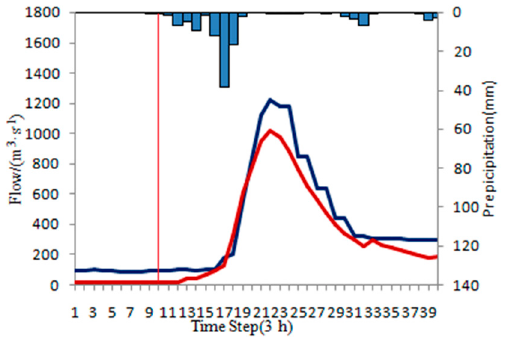
Figure 8. Over-estimated flood.